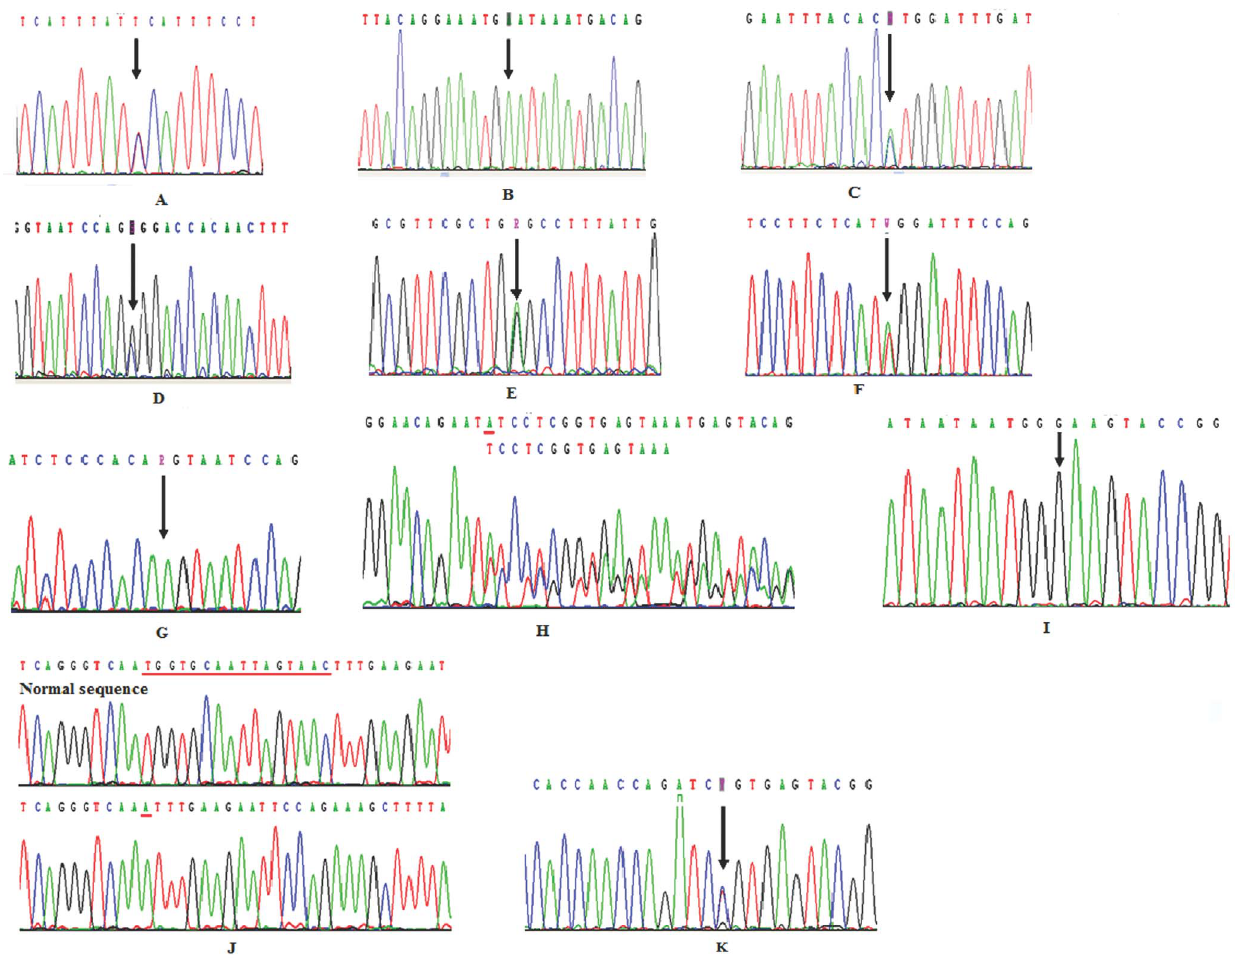
Figure 3. PHEX gene mutation sequencing diagram. (A): A nonsense mutation c.1980G . A in exon 20 was detected in Proband (II-2) from family 1. (B): Proband’s father (I-1) was hemizygous for a nonsense mutation, c.1980G . A in exon 20 from family 1. (C): A novel missense mutation, c.1751A . C in exon 17, was identified in proband (IV-1) and her mother (III-2) from family 2. (D): A novel missense mutation, c.1183G . C in exon 11, was identified in III-2 from family 2. (E): A nonsense mutation, c.1332G . A in exon 12, was identified in proband (I-2) and her daughter (II-2) from family 3. (F): A putative aberrant splicing mutation, c.1646-2A . T in intron 15, was identified in proband (III 2), his mother (II2), and his grandmother (I2) from family 4. (G): A putative aberrant splicing mutation, c.1174-1G . A in intron 10, was identified in proband (II1) and his mother (I2) from family 5. (H): A deletion mutation, c.1694delA in exon 16, was identified in proband (II1) and her mother (I2) from family 6. (I): A splicing mutation, c.1768 + 2T . G in intron 17, was identified in proband (III1) from family 7. (J): A del-insertion mutation, c.2077_*4delinsAin exon 21, was identified in proband (III1) from family 8. (K): A nonsense mutation, c.1645C . T in exon 15, was identified in proband (III1) from family 9.